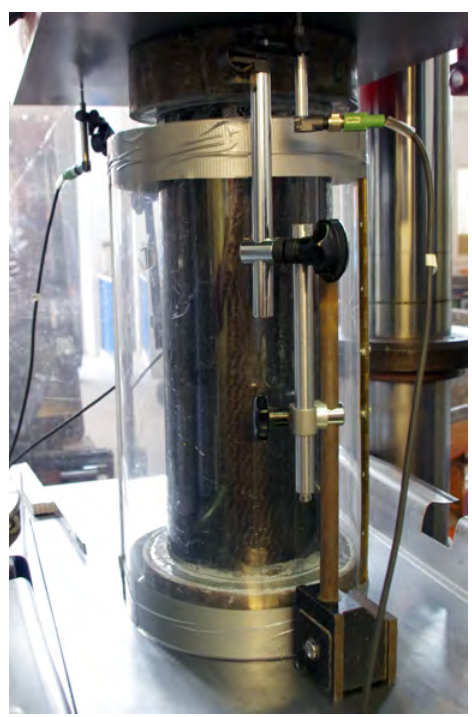
Figure 4. Experimental set-up